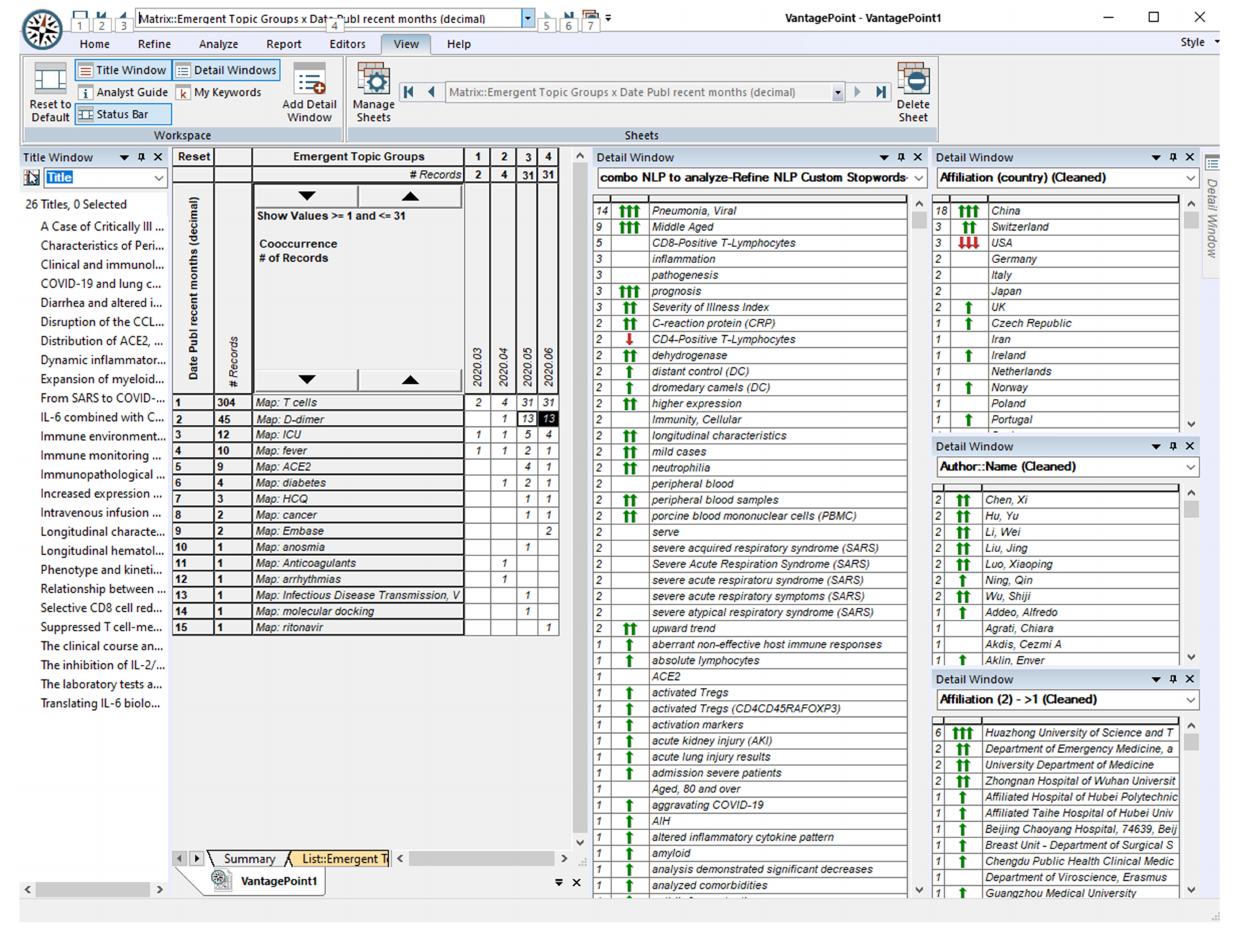
FIGURE 3 | Screenshot of VantagePoint Software: Exploring Combinations of Who, Where, When, and